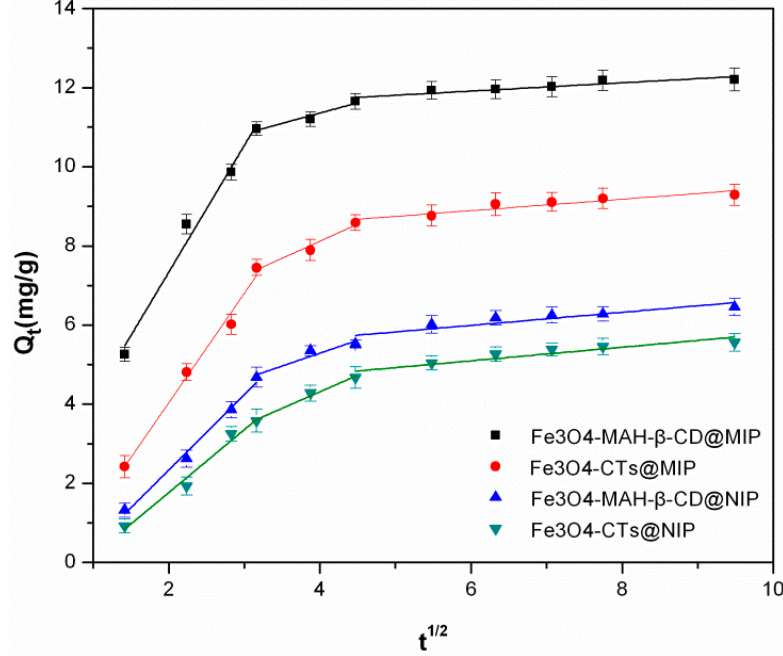
Figure 10. Intraparticle diffusion model for 2-aminopyridine adsorption onto Fe 3 O 4 -CTs@MIP, Fe 3 O 4 -CTs@NIP, Fe 3 O 4 -MAH- β -CD@MIP and Fe 3 O 4 -MAH- β